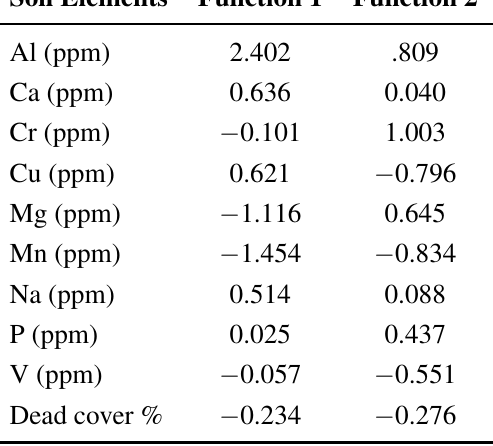
Table 6. Standardized Canonical Discriminant Function Coefficients for significant soil and vegetation variables used to assess the three sites (2011 Nest, 2012 Nest and control Site) used by Socotra Cormorants in the